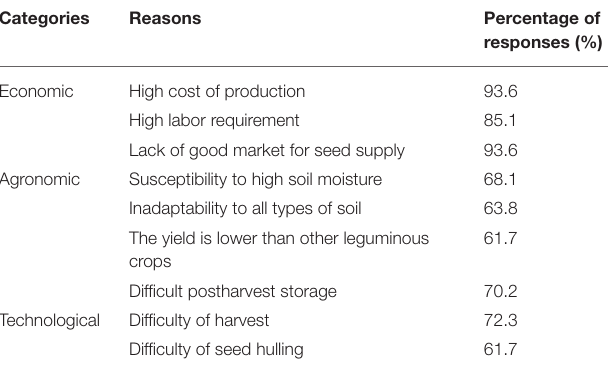
TABLE 1 | Reasons for decrease in Kersting’s groundnut production based on IITA genebank survey in year 2019 in Ondo and Benue States of